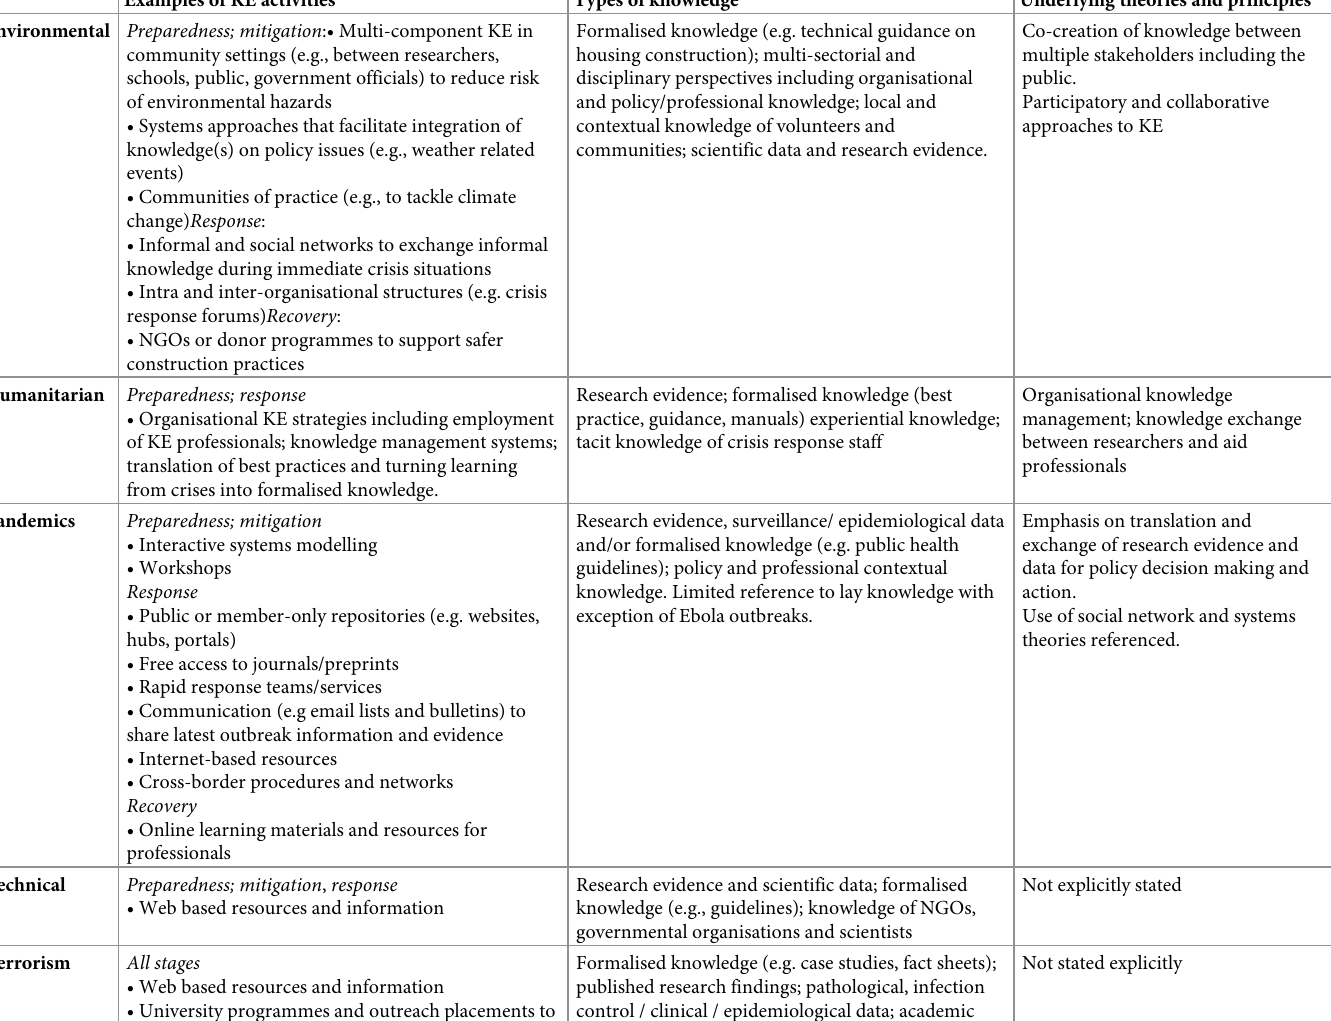
Table 4. Knowledge exchange across crisis types and